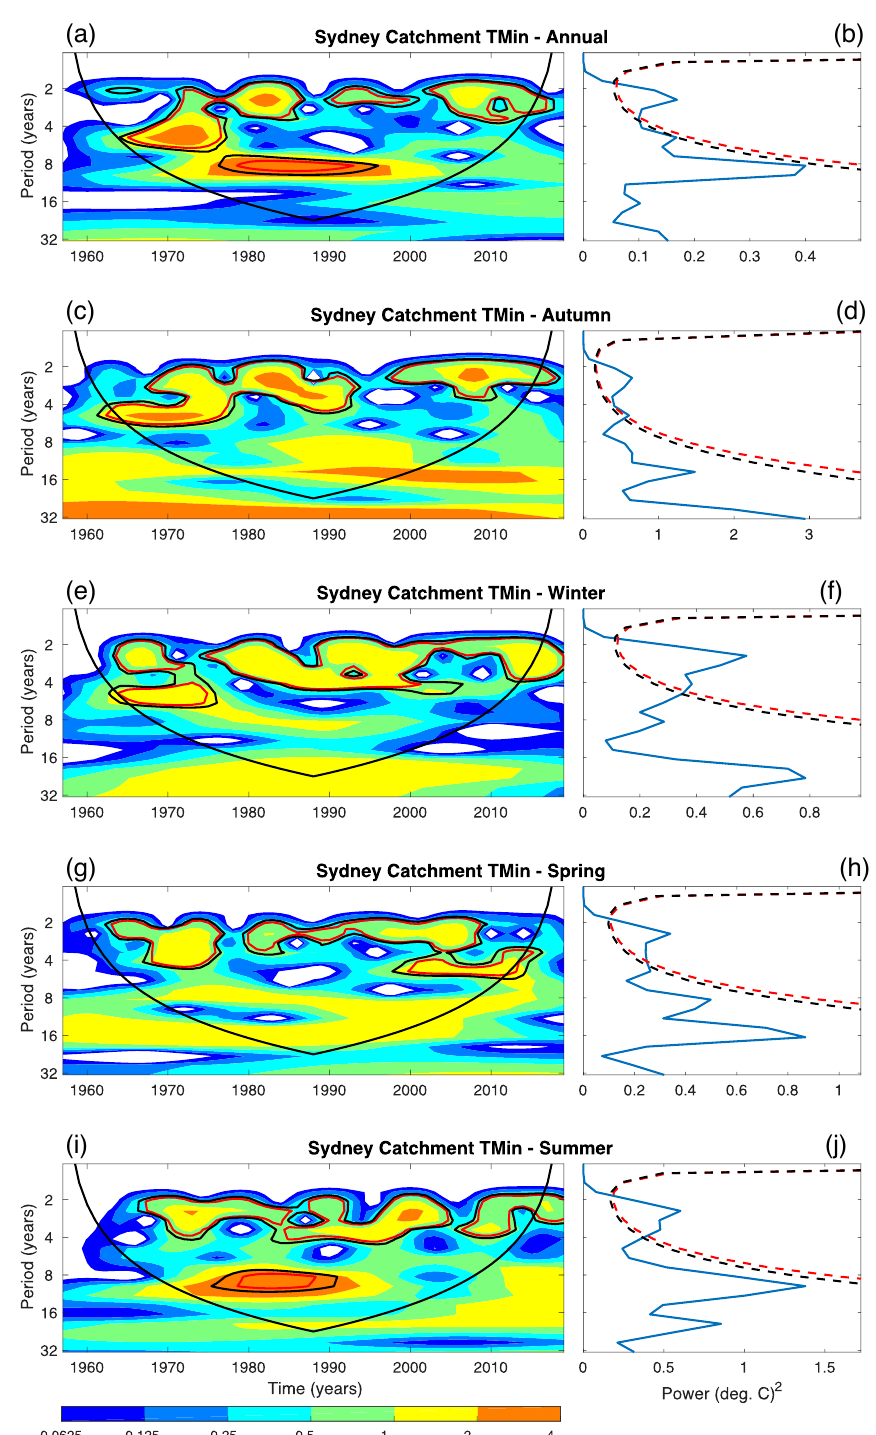
Figure 8. Wavelet power spectra (left panel, ( a , c , e , g , i )) and global power spectra (right panel, ( b , d , f , h , j )) for TMin, with low and high values in the power spectra indicating low and high periodicity, respectively; the cone of influence and statistical significance bands as already explained in Figure